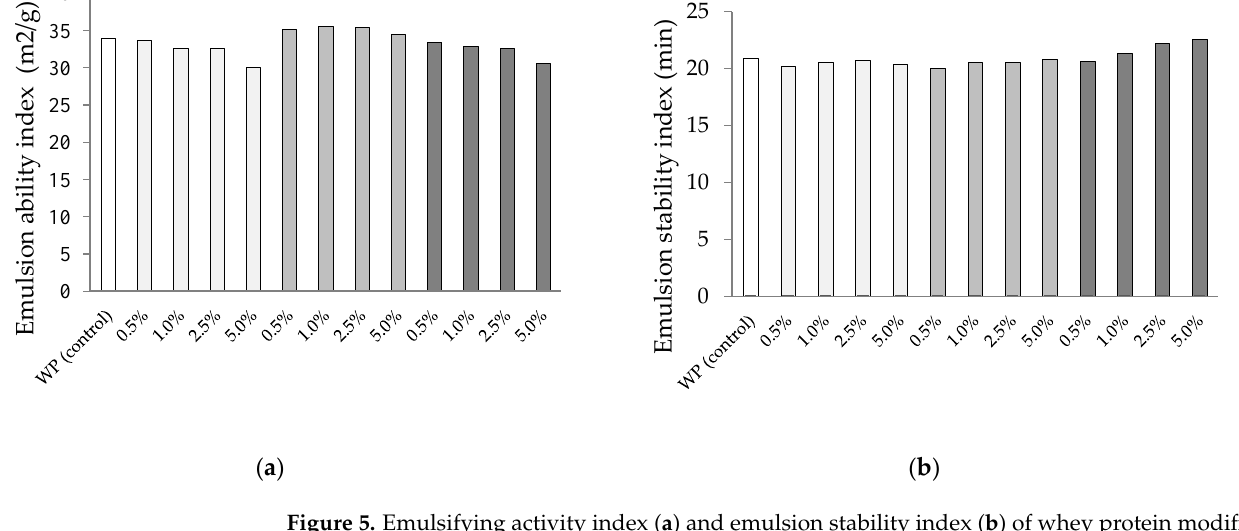
Figure 5. Emulsifying activity index ( a ) and emulsion stability index ( b ) of whey protein modified with different oxidized phenolic compounds at various concentrations. Different letters in the same concentration of oxidized phenolic compounds indicate significant differences. Different capital letters in the same type of oxidized phenolic compounds and control indicate significant differences.